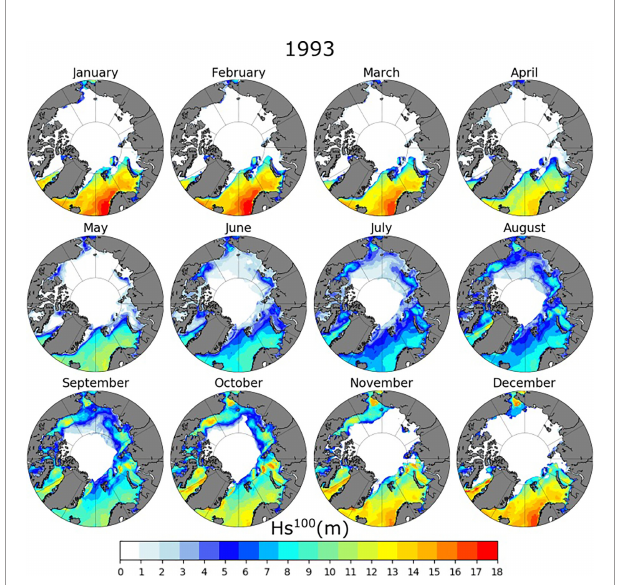
FIGURE 13 | Monthly differences in H 100 s between estimates for 2018 and 1993. Dashed lines represent the minimum sea ice coverage in the period between 1991-1993 for each month.